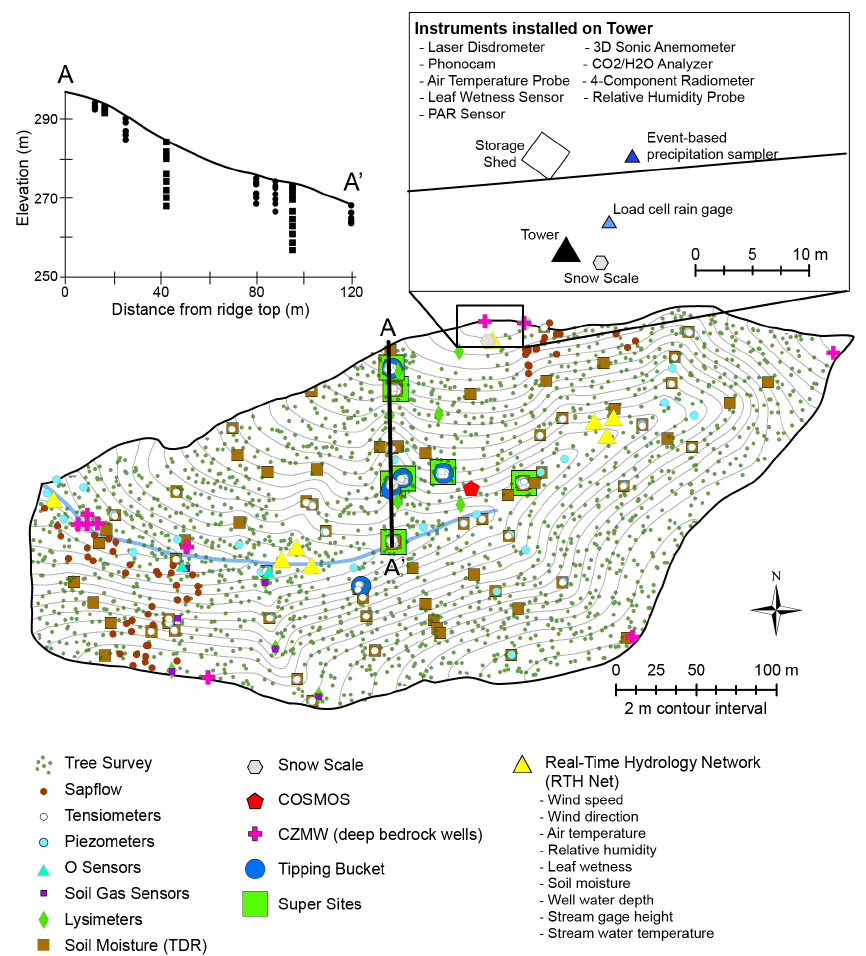
Figure 2. Mapped summary of the “everything, everywhere” sampling strategy at the Shale Hills subcatchment. Insets show soil moisture sensors (circles) and lysimeters (squares) along the transect shown on the map. Sensor and lysimeter depths are exaggerated 5 times compared to the land surface elevation. Second inset shows instrumentation deployed at the meteorological station on the northern ridge. Small green dots on the map are the trees that were surveyed and numbered: the subcatchment contains a dry oak-mixed hardwood community type (Fike, 1999) with an extremely diverse mix of hardwood and softwood species, including white oak ( Quercus alba ), sugar maple ( Acer saccharum ), pignut hickory ( Carya glabra ), eastern hemlock ( Tsuga canadensis ), and chestnut oak ( Q. montana ). The sparse understory consists of American hop hornbeam ( Ostrya virginiana ) and serviceberry ( Amelanchier spp. ). As we upscale the CZO to all of Shavers Creek, many measurements will be eliminated in the Shale Hills subcatchment as we emphasize only a Ground HOG and Tower HOG deployment as described for the Garner Run